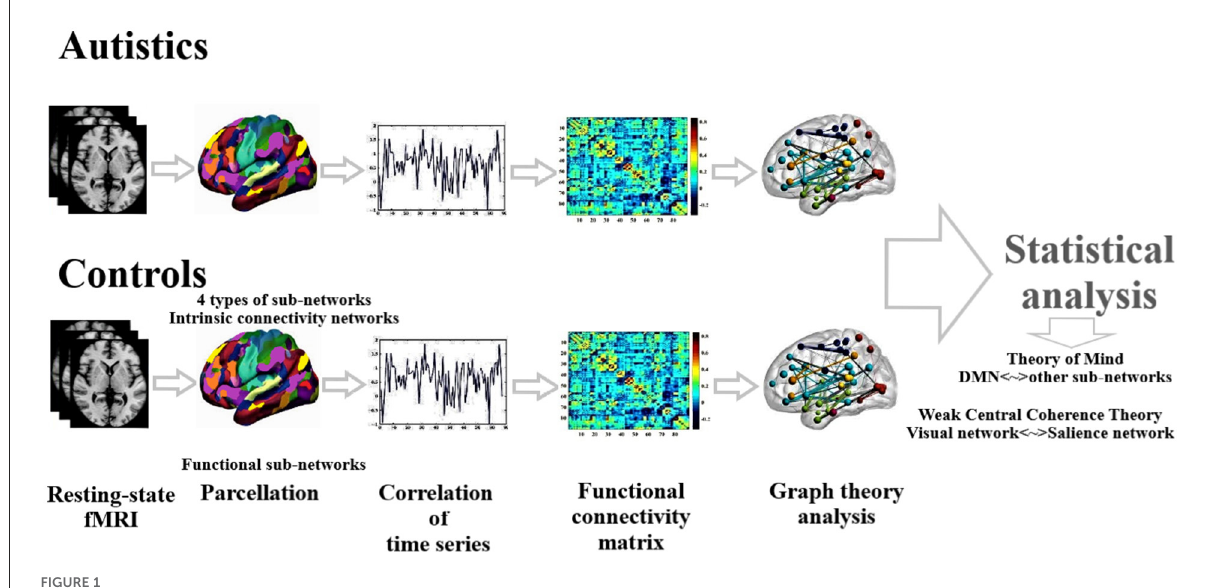
FIGURE1 Schematic diagram of data